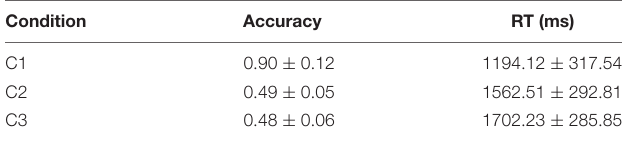
TABLE 1 | Accuracy rates (ACC) and reaction times (RT) across three conditions.